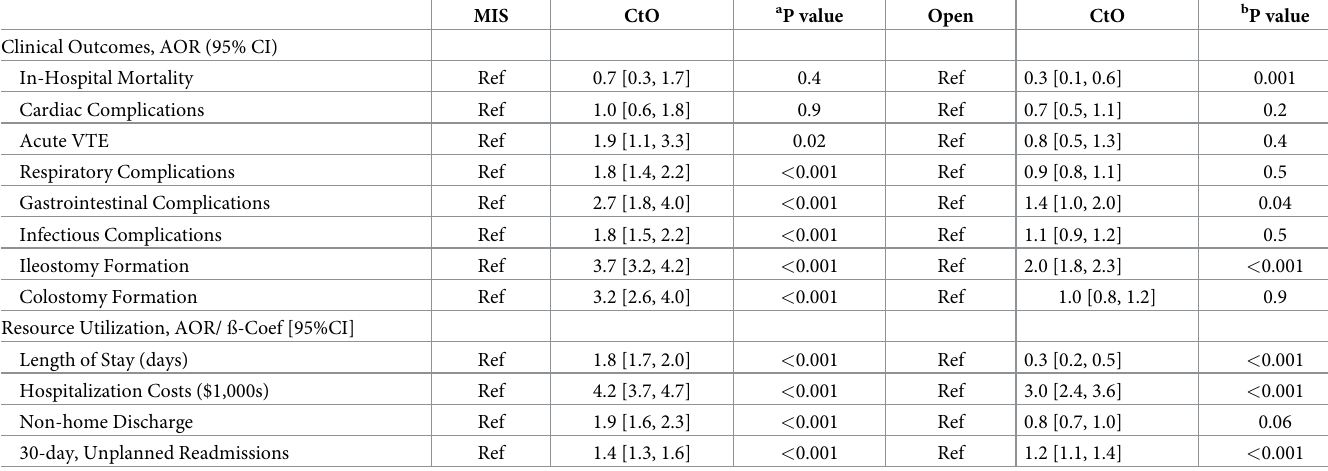
Table 3. Risk-adjusted outcomes for patients with diverticulitis undergoing elective colectomy stratified by operative